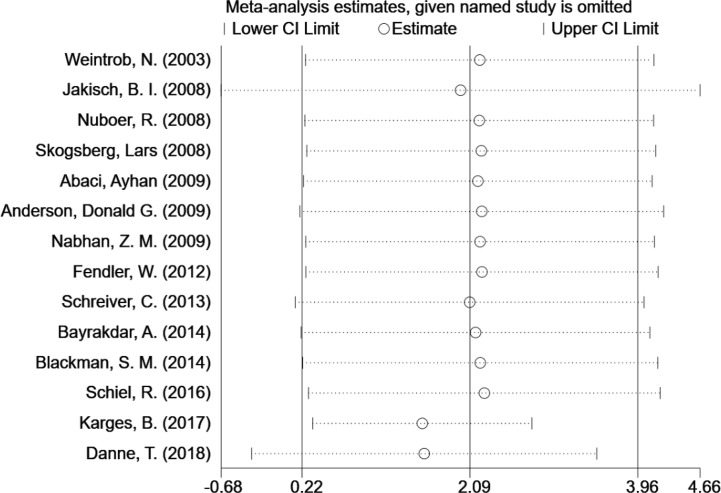
Sensitivity analysis of HbA1c in type 1 diabetes cases following MDI and CSII therapy.